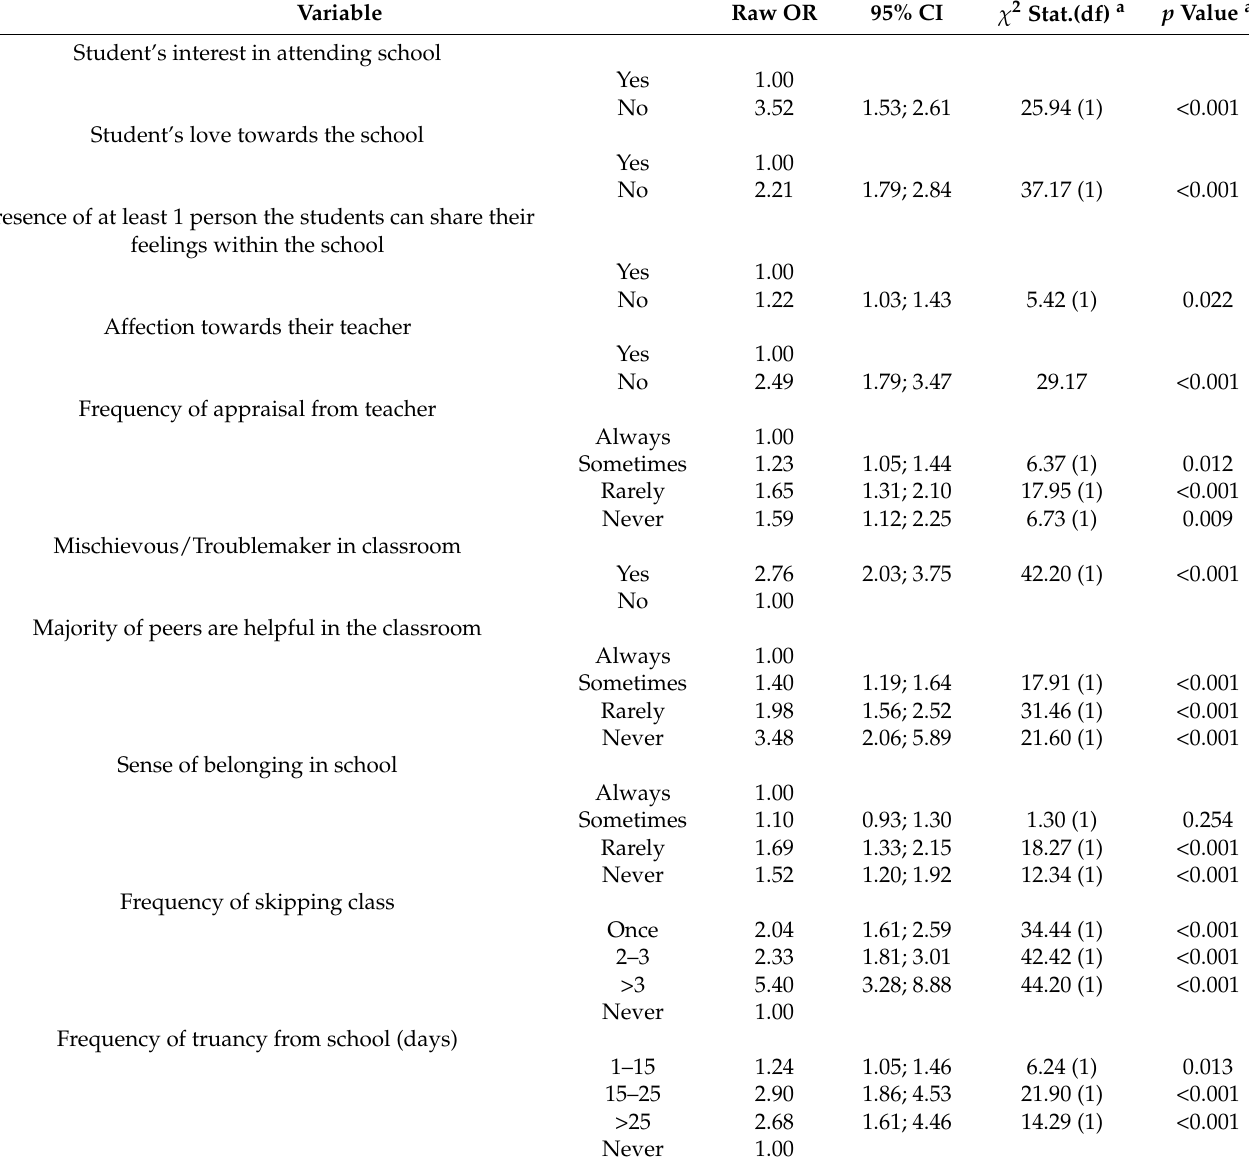
Table 8. Characteristics of school factors related to bullying involvement. Variable Raw OR 95% CI χ 2 Stat.(df)